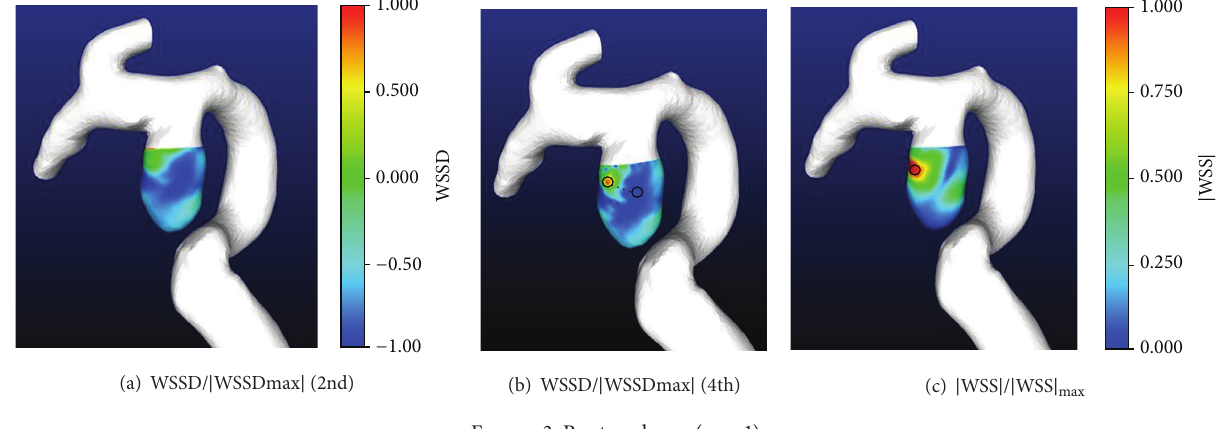
Figure 3: Ruptured case (case